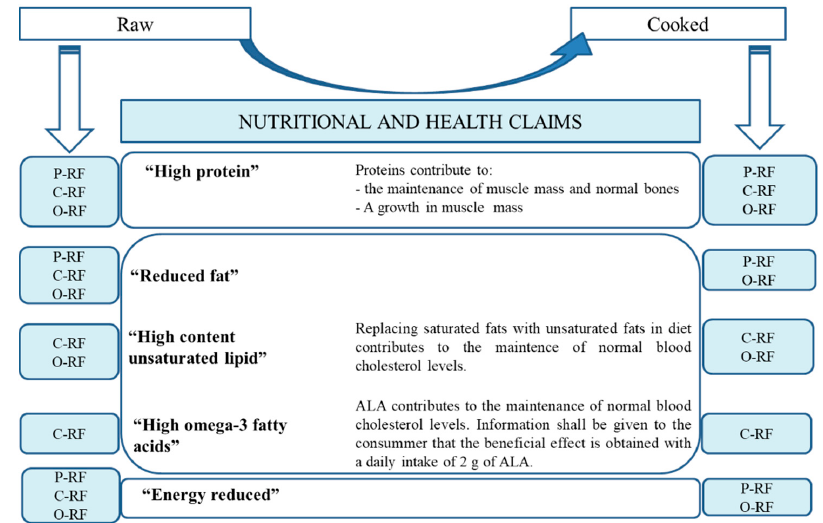
Figure 3. Nutritional and health claims of raw (left) and grilled cooked (right) longanizas. For samples denominations, see Figure 1; ALA: α -linolenic fatty acid .